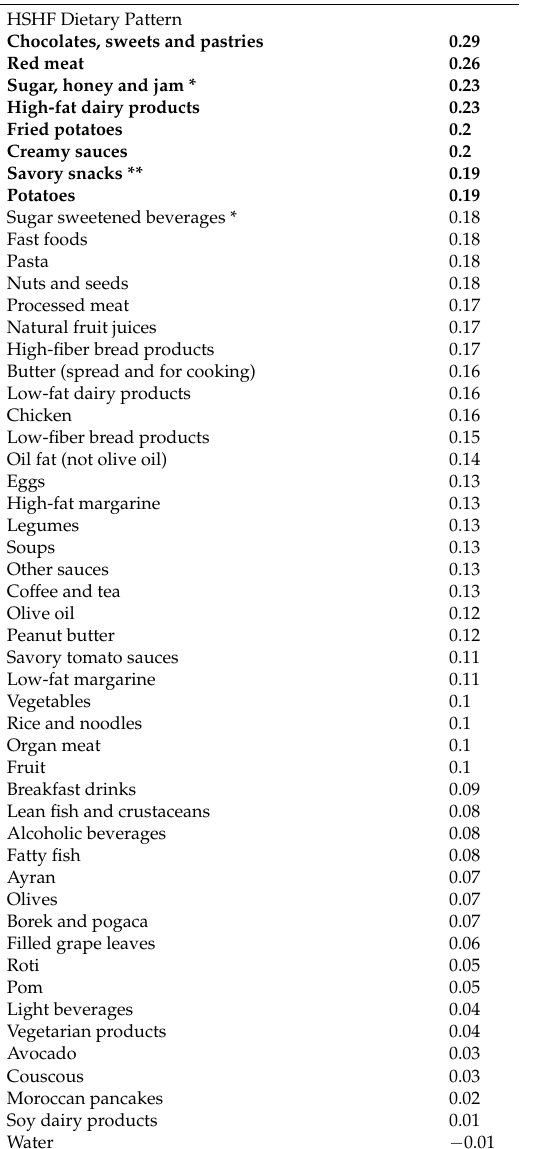
Table A1. Overview of all food groups included as predictor variables with their corresponding factor loadings derived by RRR in the HELIUS